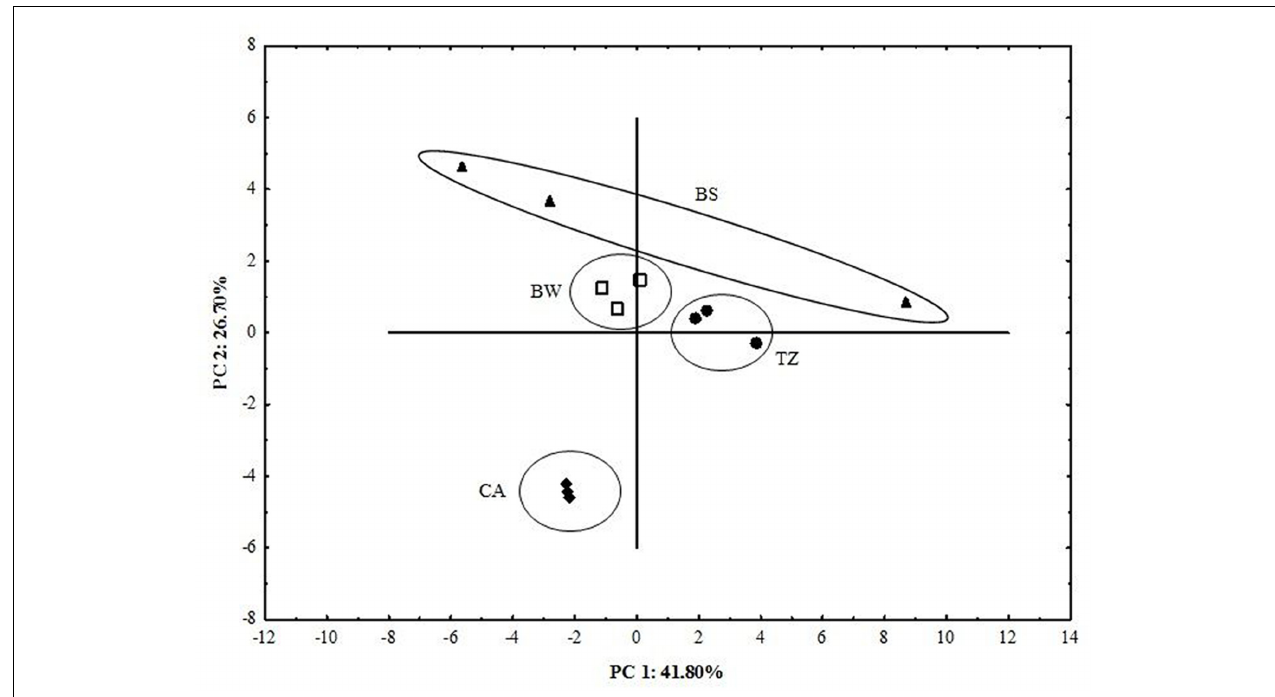
FIGURE 4 | Principal components analysis (PCA loadings) on variables data of carbon sources activity from the BW, TZ, BS, and CA.